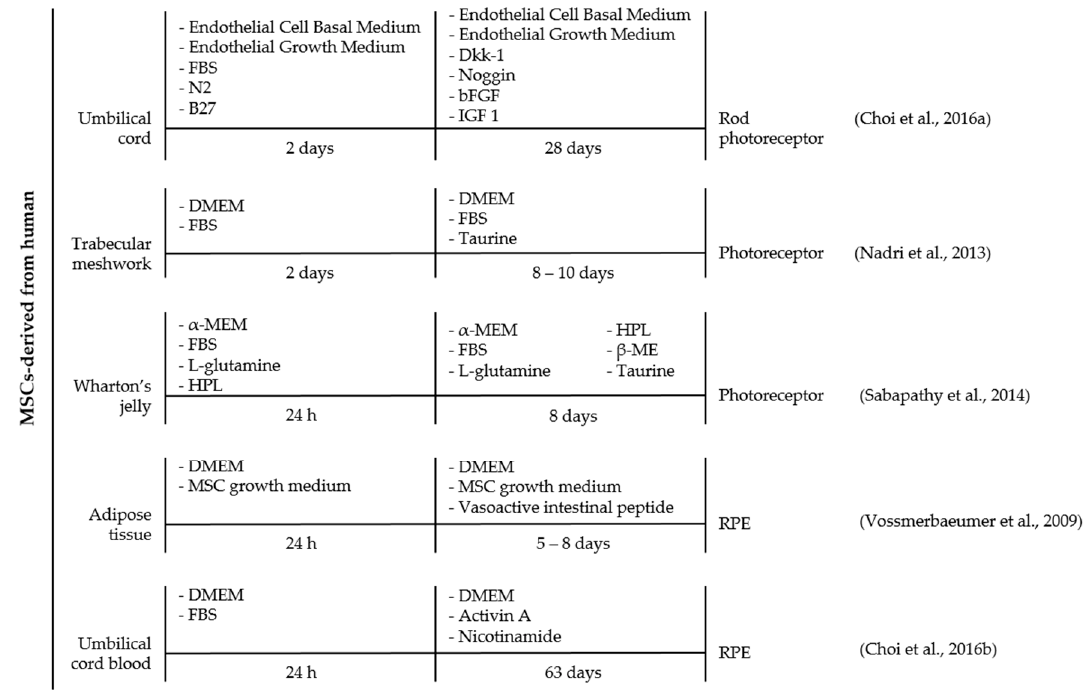
Figure 4. A timeline representation of strategies used to direct human MSCs differentiation into retinal neurons and retinal pigmented epithelial cells, in vitro. Generation of retinal cell from MSCs involve the manipulation of stem cell fate by cytokines, growth factors, or inhibitory peptides. MSCs derived from different tissue origins including bone marrow, dental pulp, umbilical cord, trabecular meshwork, Wharton’s jelly, adipose tissue, and umbilical cord blood have previously demonstrated successful differentiation potential into retinal cells. The vast differentiation potential of MSCs into retinal cells includes photoreceptor, amacrine cell, RGC, and RPE-like cells that requires addition of specific cytokines, growth factors or inhibitory peptides. The differentiation factors are comprised of either taurine, activin A, basic Fibroblast Growth Factor (bFGF), β -mercaptoethanol ( β -ME), Dickkopf Wnt signaling pathway inhibitor-1 (Dkk-1), noggin, insulin growth factor 1 (IGF 1), Human Platelet Lysate (HPL), and Vasoactive Intestinal Peptide. FBS, Fetal Bovine Serum; DMEM, Dulbecco’s Modified Eagle Medium; α -MEM, alpha Minimal Essential Medium; B27, B27 supplement; and N2, N2 supplement.